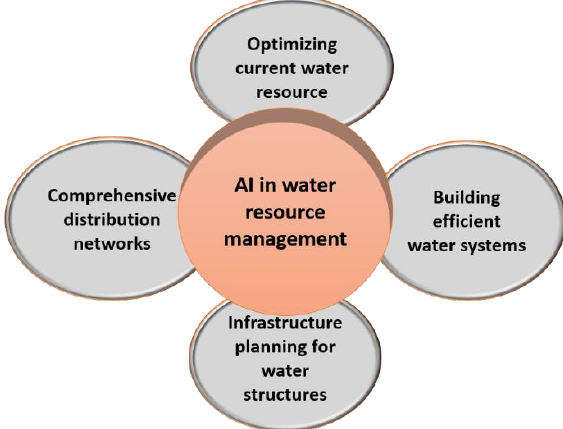
Figure 8. Some of the potentials of AI in the water industry.